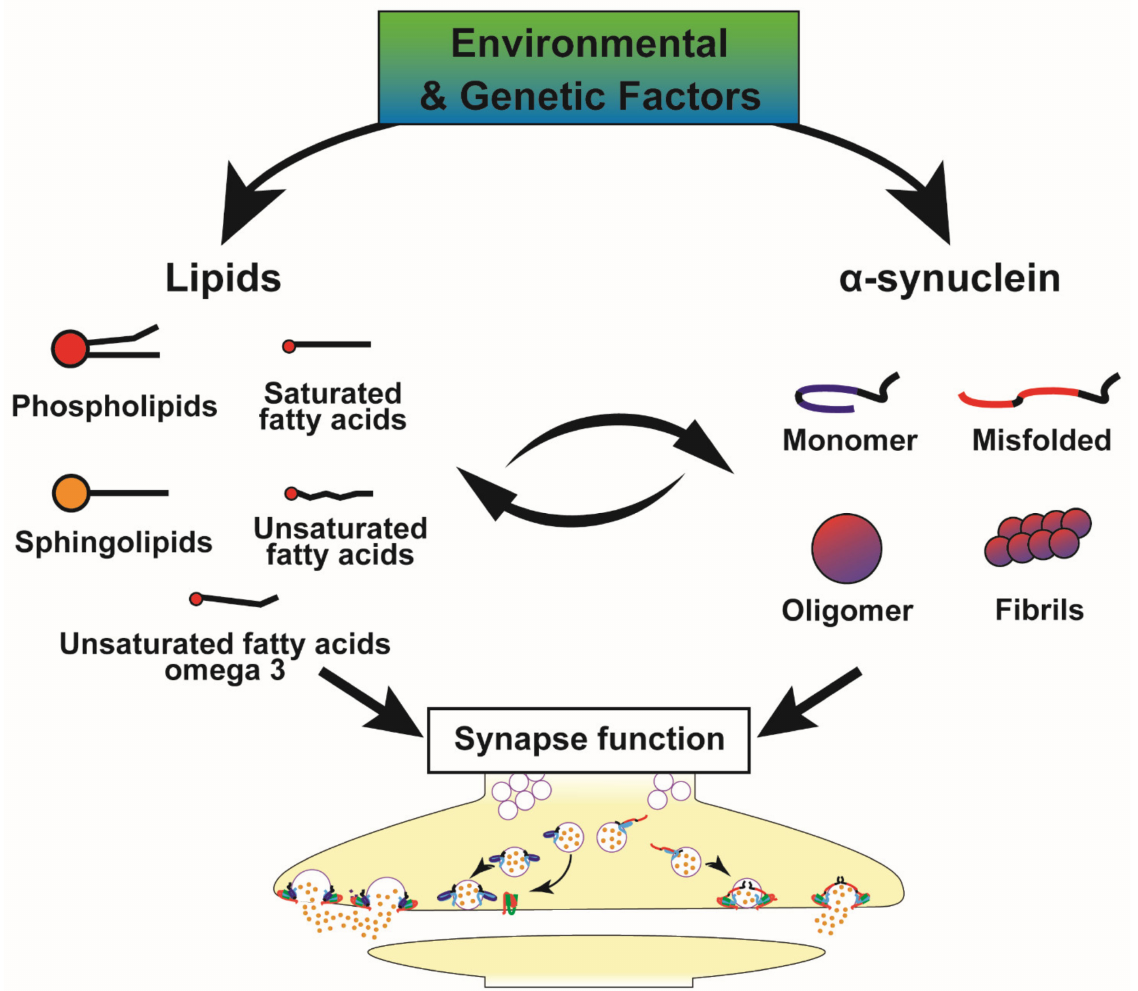
Figure 5. Schematic representation of genetic and environmental factors supporting the role of lipids in PD and synaptic homeostasis. The environmental factors include chemicals and toxins. Among the genetic determinants associated with α -synuclein ( α -syn) pathology, many are associated with lipid metabolism or transport, such as Ataxin2 gene ( ATXN2 ), Chromosome 19 Open Reading Frame 12 gene ( C19orf12 ) , Galactosylceramidase gene ( GALC ), Glucosylceramidase β gene ( GBA ), Diacylglycerol Kinase Theta gene ( DGKQ ) , ELOVL fatty acid elongase gene ( ELOVL7 ), Phospholipase A2 group VI gene ( PLA2G6 ) , Scavenger Receptor Class B Member 2 gene ( SCARB2 ), Non-A4 Component Of Amyloid Precursor (SNCA), Sterol Regulatory Element Binding Transcription Factor 1 gene ( SREBF-1 ), and Vacuolar Protein Sorting 13 homolog C gene ( VPS13C ). Mutations in these genes are responsible for lipid alterations that can trigger the α -syn oligomerisation and consequentially compromise the α -syn synaptic dysfunctions. Aberrant forms of α -syn can also affect the lipids by modifying the membrane integrity [186]. Other parkinsonism-related genes link to vesicular trafficking includes ATPase H+ Transporting Accessory Protein 2 gene ( ATP6AP2 ), ATPase Cation Transporting 13A2 gene ( ATP13A2 ), Parkinsonism Associated Deglycase gene ( DJ1 ), DnaJ Heat Shock Protein Family (Hsp40) Member C6 gene ( DNAJC6 ), Leucine Rich Repeat Kinase 2 gene ( LRRK2 ), PTEN Induced Kinase 1 gene ( PINK 1), Ras-Related Protein Rab-29 gene ( RAB29 ), Ras-Related Protein Rab-39B gene ( RAB39B ), Synaptojanin 1 gene ( SYNJ1 ), Synaptotagmin 11 gene ( SYT11 ), and VPS35 Retromer Complex Component gene (VPS35 ) may be involved in deregulation of lipid homeostasis (see for review [157]). Physiological synaptic activity mediated by α -syn requires the co-operation of membranes and soluble interactors including lipidic components and protein partners (Table 3). Any disruption of the expression, localisation, interaction of α -syn and/or the above-mentioned partners can induce alterations at different levels of vesicle trafficking processes resulting in an altered neurotransmission and synaptic communication. Membrane phospholipids play an important role in this respect. Indeed, the α -syn-lipid interaction may represent an important step leading to conformational change and physiological multimerisation of α -syn [187]. It seems likely that any variation in membrane lipid composition or expression level of α -syn as well as the presence of α -syn mutant may compromise the α -syn binding properties and functions of α